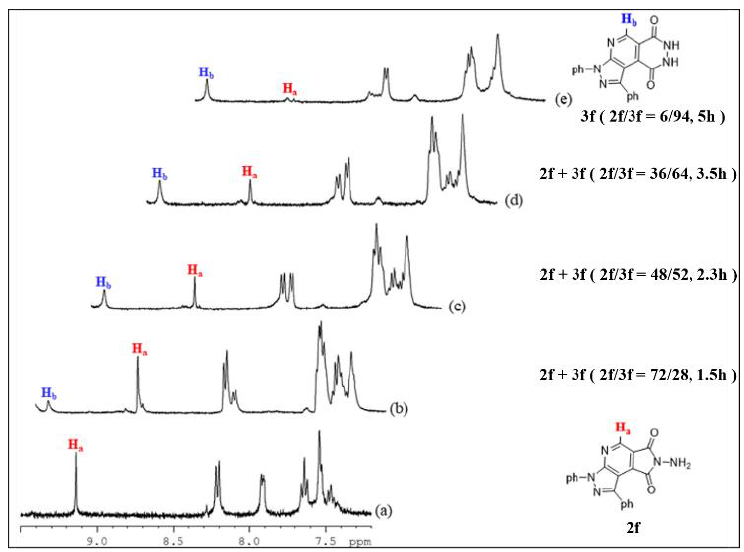
Figure 4. ( a ) 1 H NMR spectrum of the beginning of the reaction ( 1 H NMR of compound 2f ). ( b – d ) Reaction at reflux for 1.5, 2.3, and 3.5 h ( 1 H NMR of compounds 2f and 3f ; the ratios of 2f / 3f = ~72/28, 48/52, and 36/64). ( e ) Reaction at reflux for 5 h ( 1 H NMR of compounds 3f ; the ratios of 2f / 3f = ~6/94). Table 4. The conversion results between N -aminophthalimide 2a – e and pyrazolopyridopyridazine dione 3a – e .